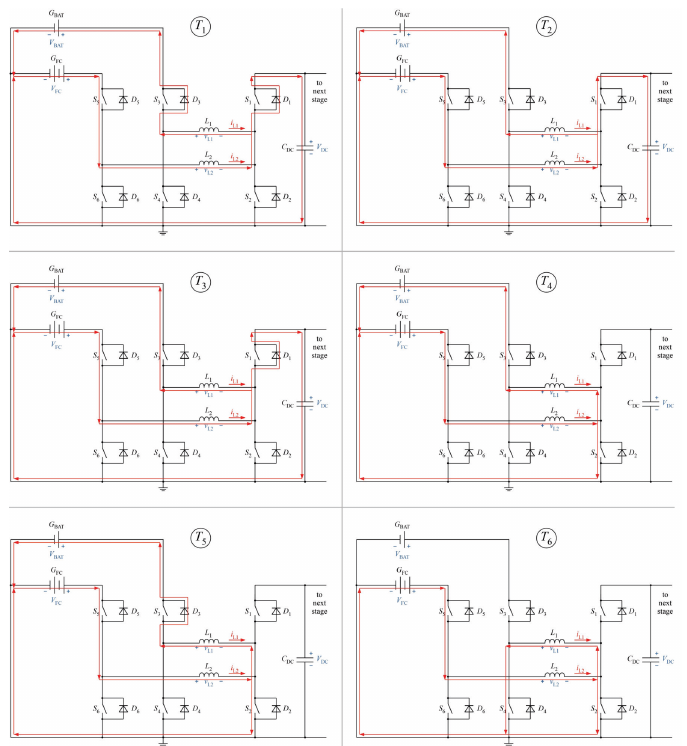
Figure 17. Current flow in FC2BDC- Boost mode for time intervals T 1 – T 6